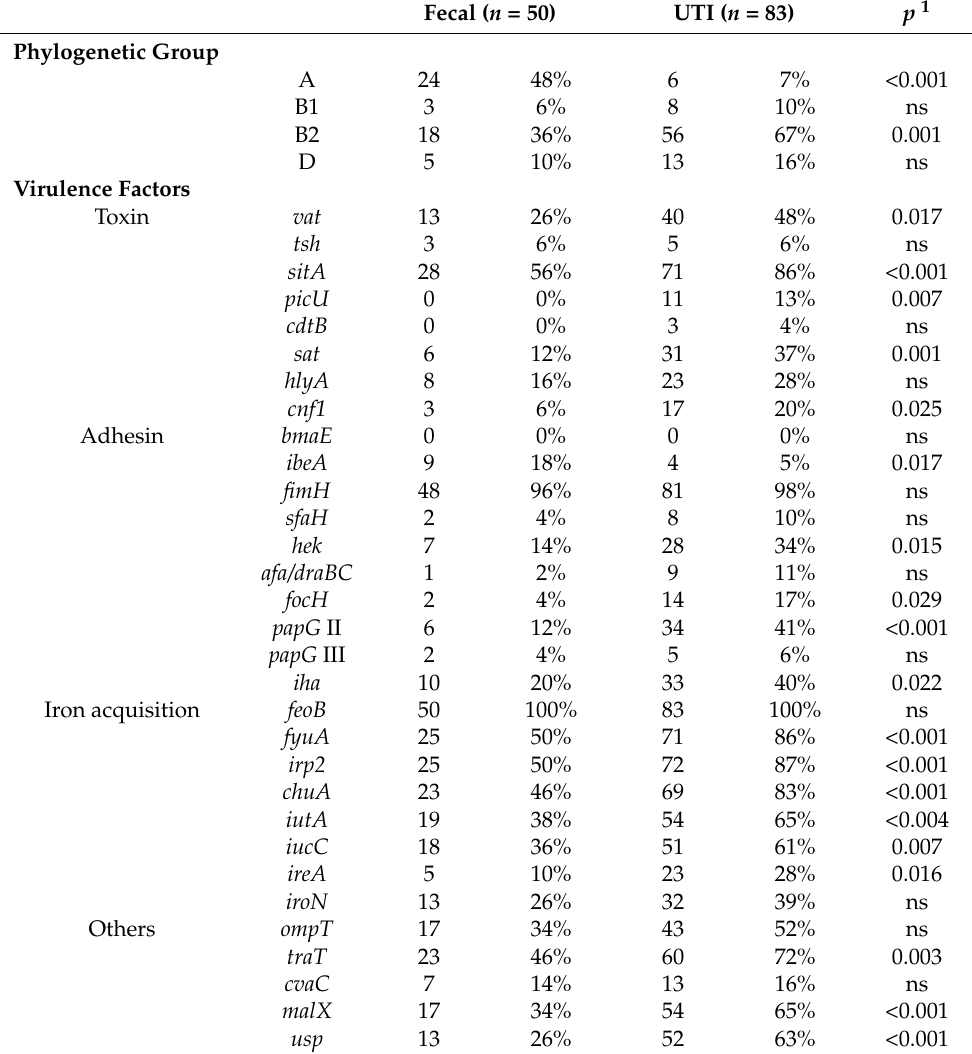
Table 1. Characterization of the 133 E. coli clinical